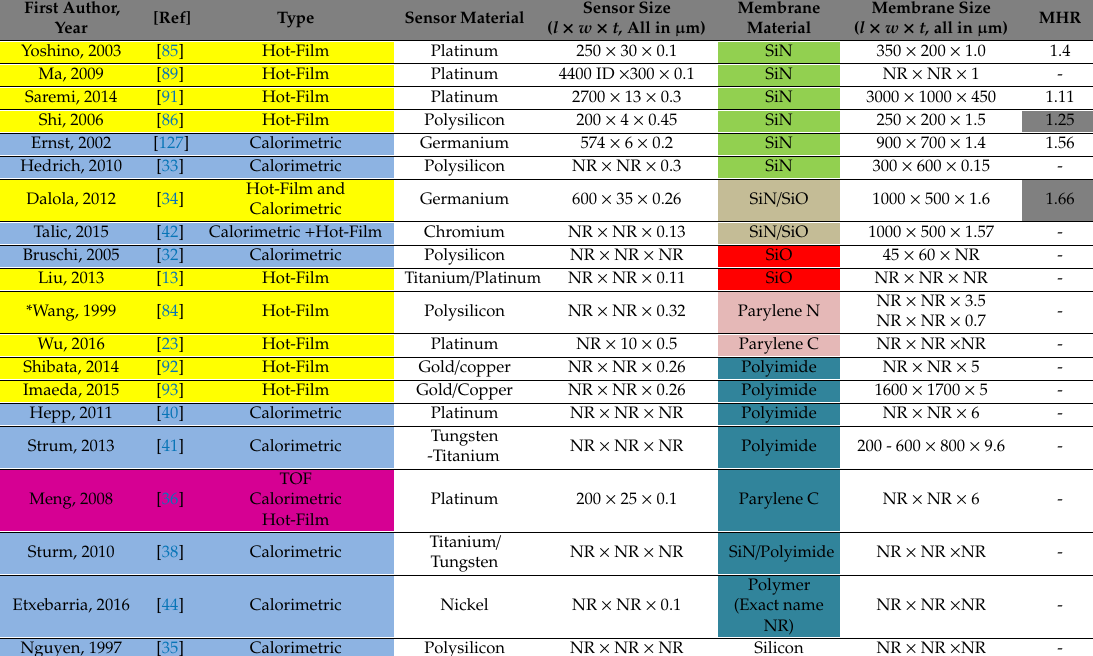
Table 5. MEMS Thermal Flow Sensors with Rectangular